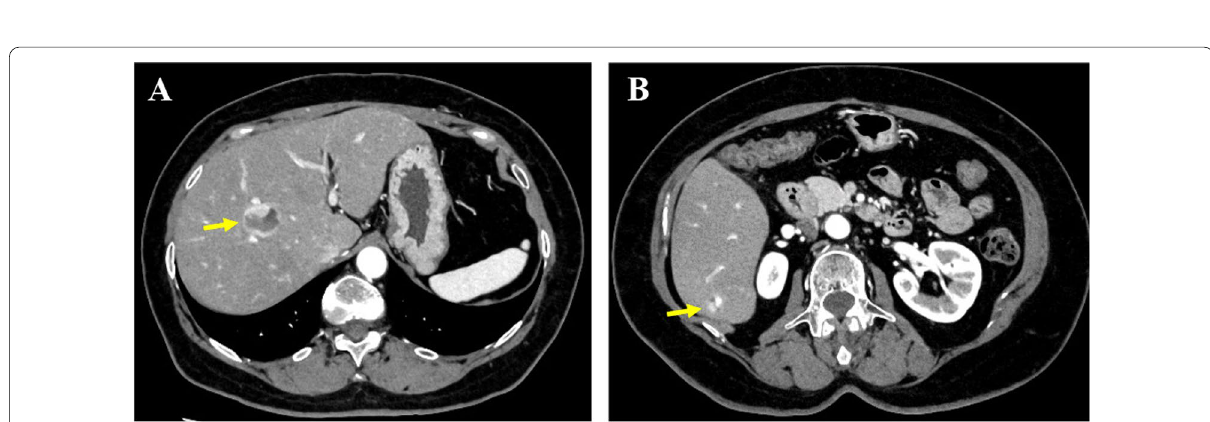
Fig. 4 Contrast-enhanced computed tomography at the follow-up visit 2 years postoperatively. A A 26- 10- 10-mm mass in S6 (arrow) were shown as hypervascular lesions in the early phase on contrast-enhanced computed ×